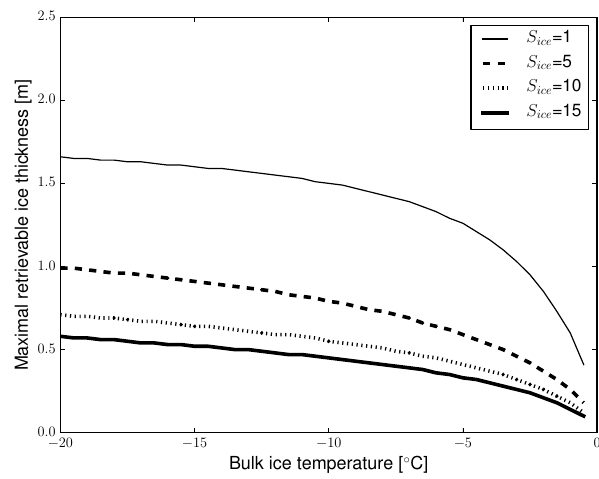
Figure 6. d max under different T ice [ ◦ C] and S ice [gkg − 1 ].